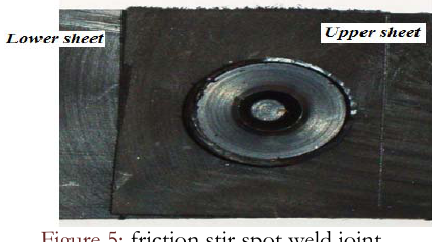
Figure 5: friction stir spot weld joint.